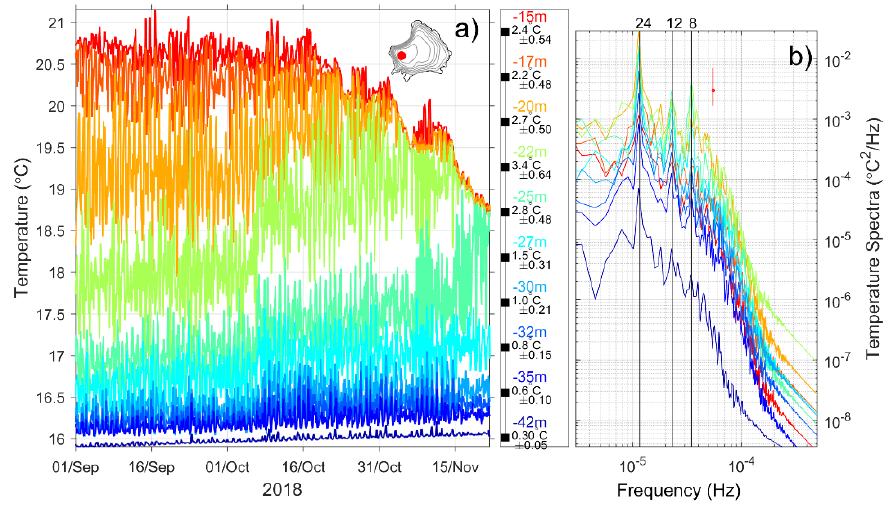
Figure 8. Thermistor chain time series in ( a ) for the field campaign from 1 September to 22 November. The colored lines correspond to the thermistor depths. Inset map shows the location of the thermistor chain in the lake. In the right side, every thermistor is shown in color-coded manner, the position in meters (first number), amplitude range in ◦ C (second number), and standard deviation in ◦ C (third number). Next, toward the right in ( b ), the temperature power spectral density is shown. The three top numbers correspond to periods in hours. The red bar is the 95% confidence interval